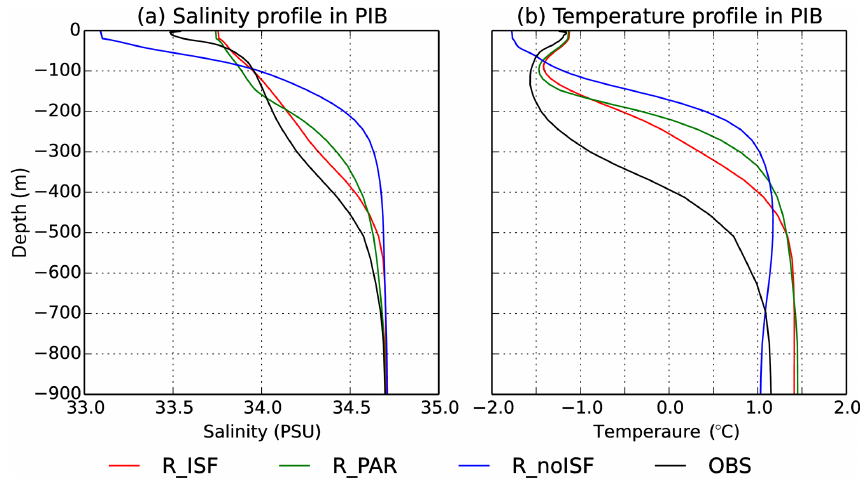
Figure 9. Profiles (year 10, 1988) in Pine Island Bay in R_noISF (blue), R_ISF (red) and R_PAR (green) of (a) salinity and (b) temperature. Climatology from 1994 to 2012 (Dutrieux et al., 2014) is in